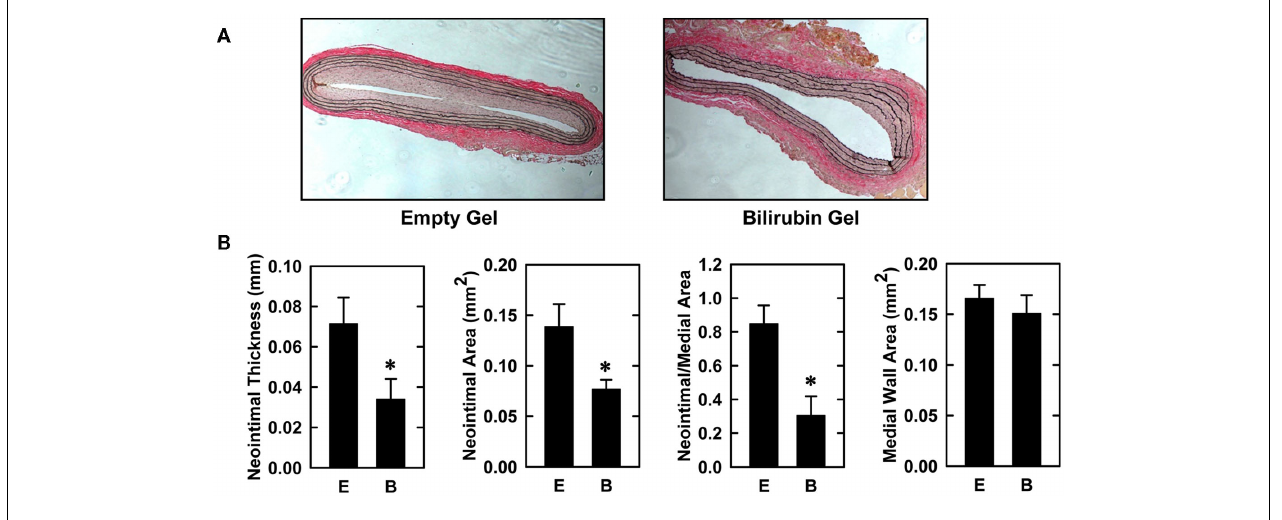
(original magnification, 100 × ). (B) Morphometric analysis of neointima formation 2weeks after arterial injury. Results are means ± SEM ( n = 7). *Statistically significant effect of